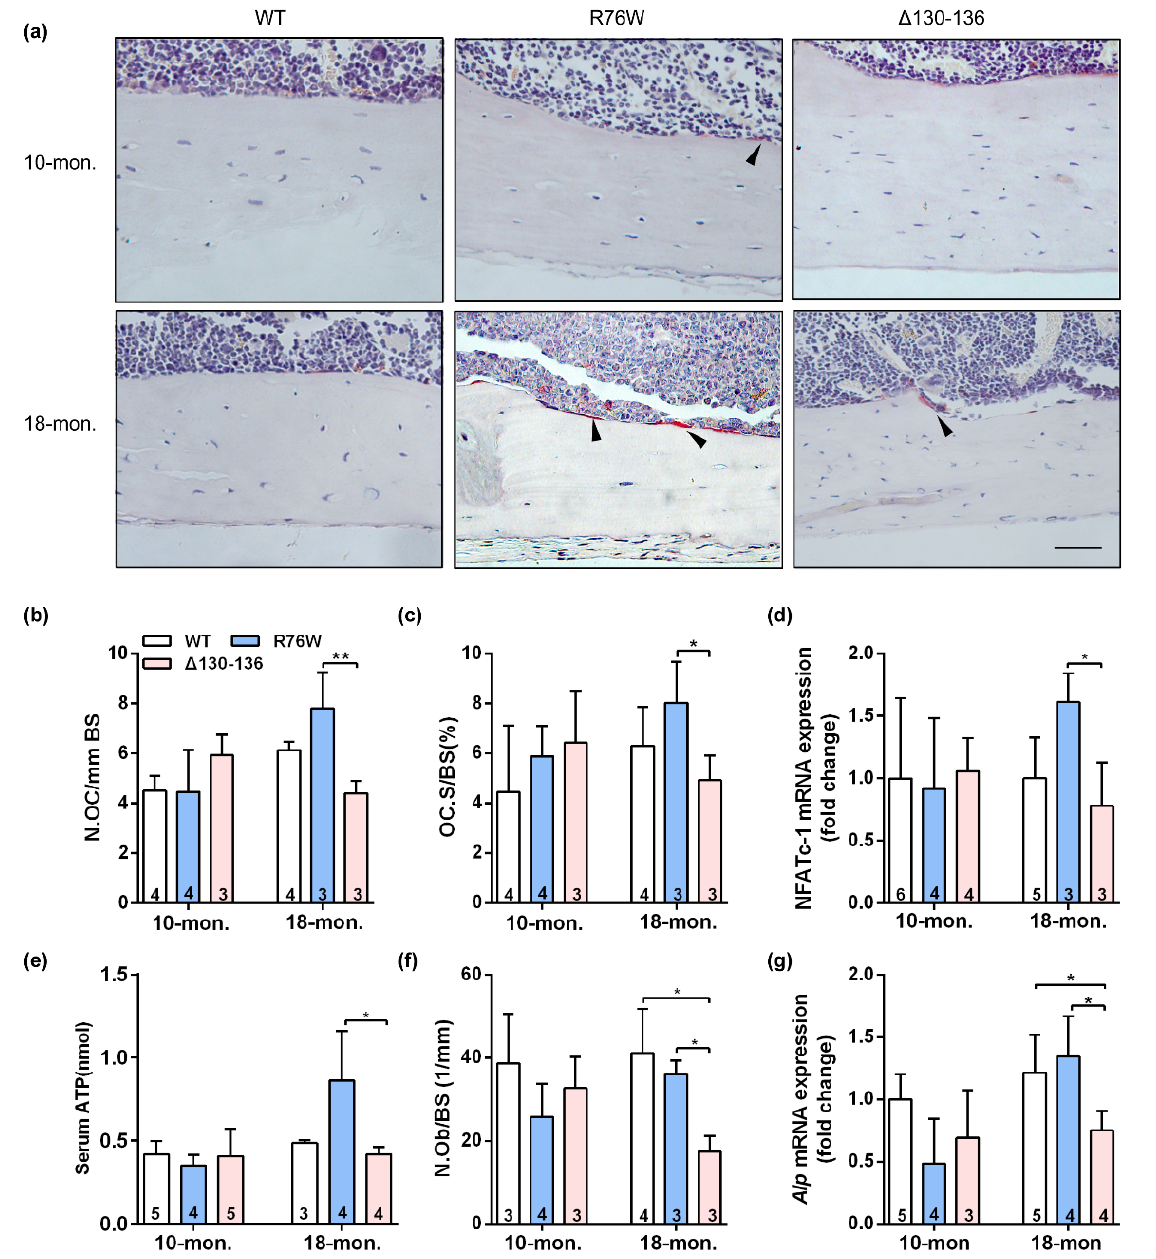
Figure 3. Effects of Cx43 channels on endocortical osteoclasts number and surfaces in transgenic mice. ( a ) Representative TRAP staining images of tibial cortical bone 10- and 18-month-old transgenic mice and their littermates. The black arrows indicate osteoclasts on bone surface. Scale bar = 50 µ m. ( b , c ) The number and surface of osteoclasts were estimated by N.Oc/BS ( b ) and Oc.S/BS ( c ), respectively. ( d ) Real-time PCR analysis of mRNA expression of NFATc-1 in tibia. ( e ) Serum concentration of ATP by ELISA assay in mice. ( f ) The number of osteoblasts were evaluated by N.Ob/BS. ( g ) Real-time PCR analysis of Alp in tibia. Sample sizes are indicated at the bottom of each column. * p < 0.05; ** p < 0.01.